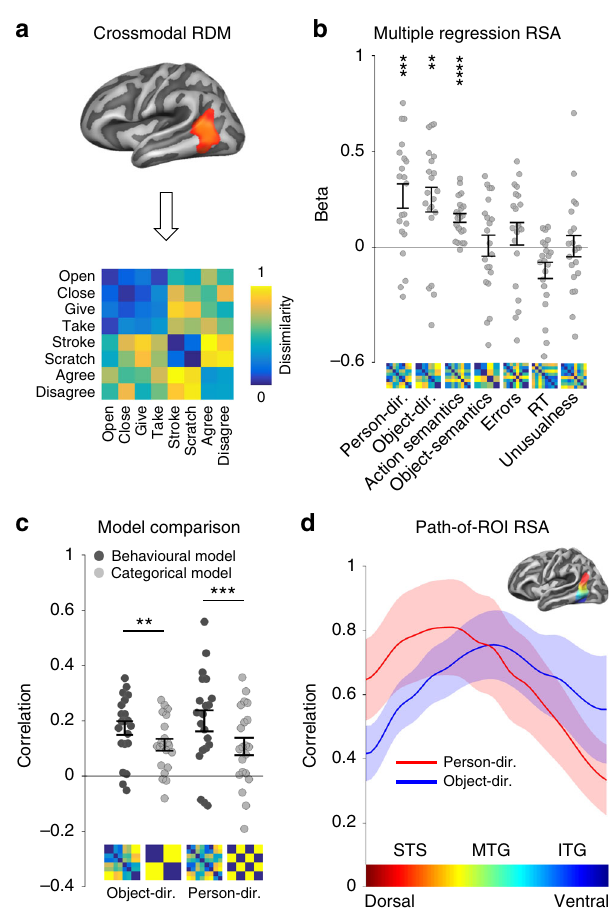
Fig. 3 Crossmodal RSA. a Classi fi cation matrices were extracted from left LPTC, averaged, and converted into a dissimilarity matrix for each participant (see Methods for details; displayed matrix averaged across participants, rank-transformed, and scaled 66 ). b Multiple regression RSA.